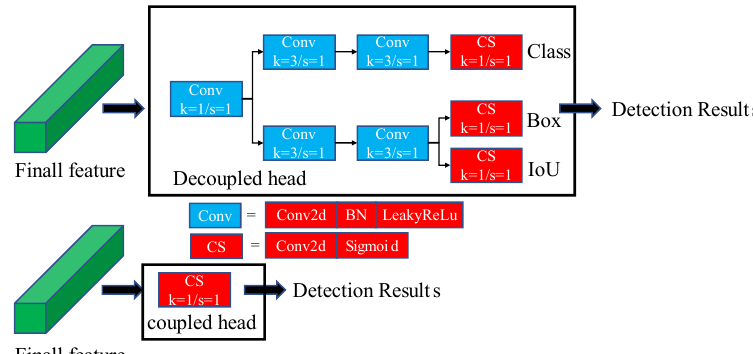
Figure 5. The structure of the decoupled head and coupled head. Compared to coupled head, the decoupled head has more convolution layers.